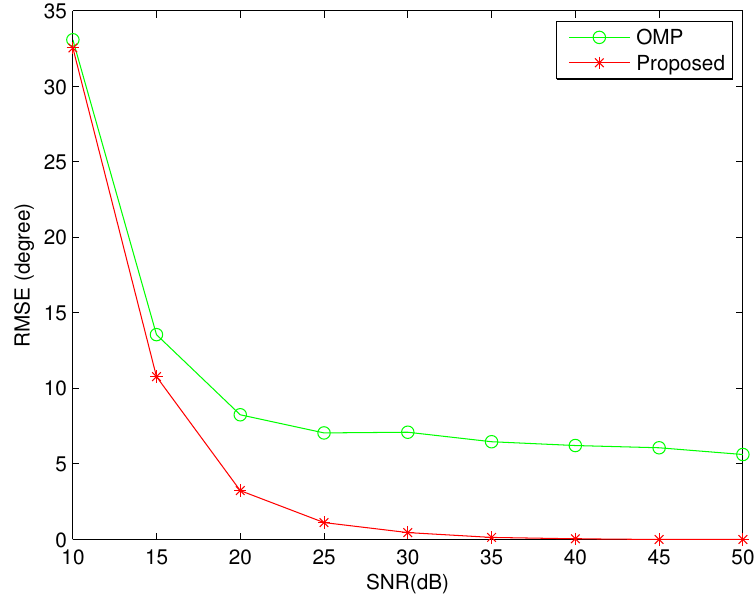
Figure 5. The performance comparison in the ideal case. Four sources are assumed from the DOAs: {− 36 . 1 ◦ , 4 . 1 ◦ , 8 . 1 ◦ , 54 . 1 ◦ } . The power of the sources and noise is 10 dB and